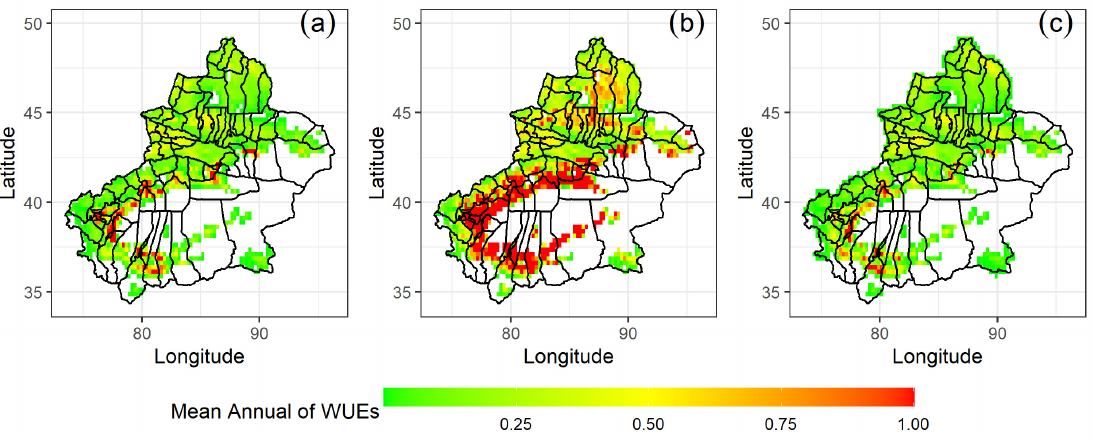
Figure 6. Spatial distribution of WUEs during 2000 – 2014; ( a ) eWUE; ( b ) tWUE; ( c ) pWUE.